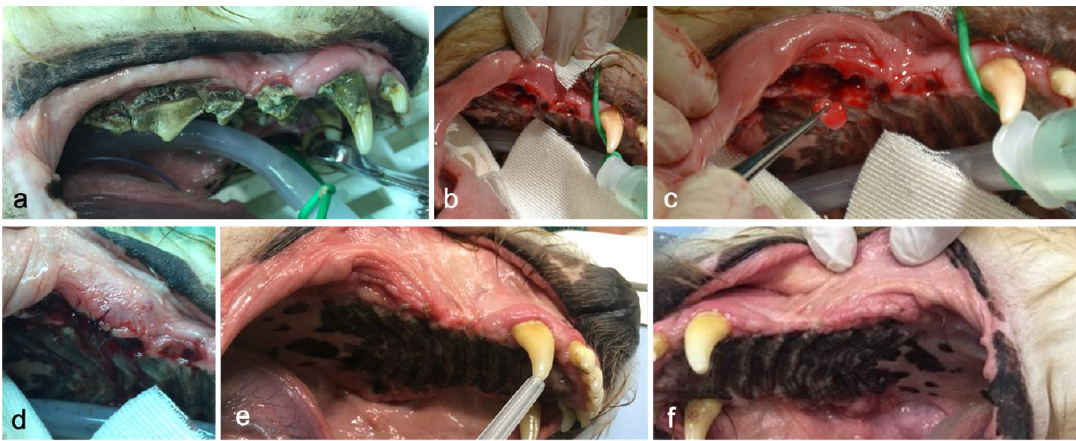
Figure 3. Clinical appearance in various stages of treatment and evaluation protocols: ( a ) pre-operative condition at recruitment; ( b ) intraoperative condition of post-extraction sockets; ( c ) intraoperative condition, application of PRF in the treated side (group PRF); ( d ) post-operative condition immediately after suturing of the mucogingival flap; ( e ) split-mouth treated side (group PRF) after a three-week follow-up (T1); ( f ) split-mouth control side (group C) after a three-week follow-up (T1).